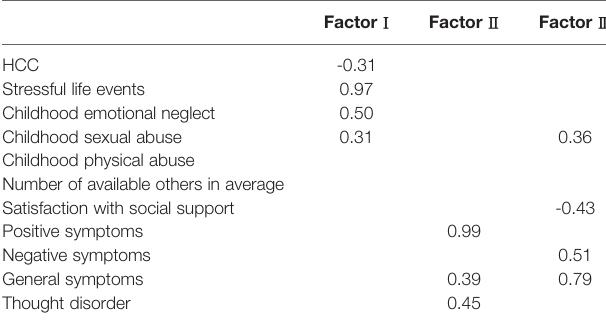
TABLE 5 | Exploratory factor analysis of HCC, childhood trauma, social support, and symptoms.